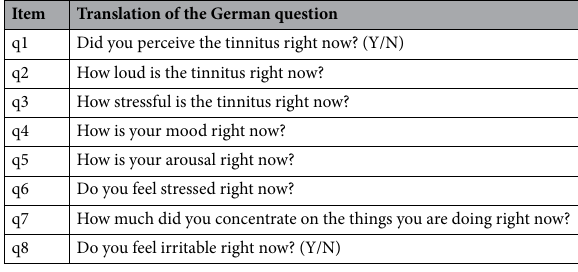
Table 1. EMA questionnaire of TYT 26